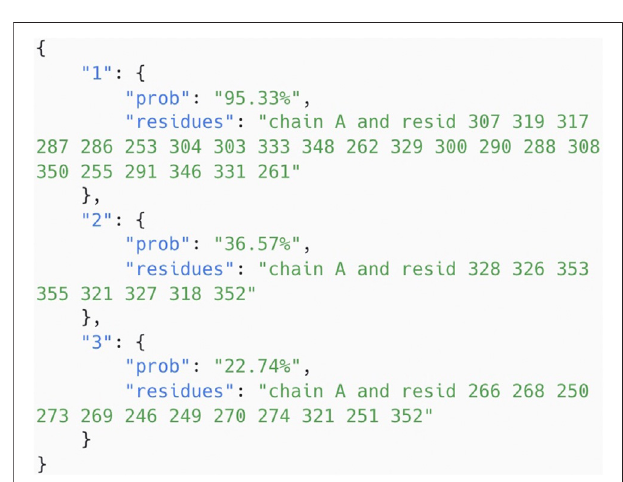
FIGURE 5 | Allosteric probability results of chain A of protein 5DKK returned by command line API of PASSer.